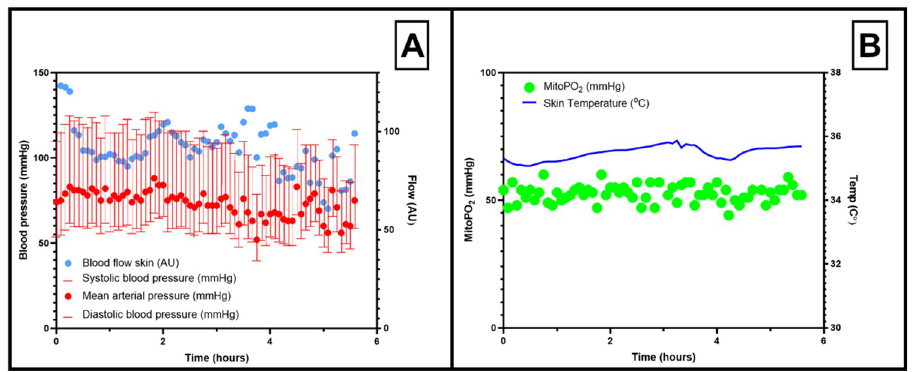
Fig 4. Representative case of stable mitoPO 2 measurements during an operation of more than six hours. MitoPO 2; mitochondrial oxygen tension, AU; arbitrary units, Temp; skin temperature.